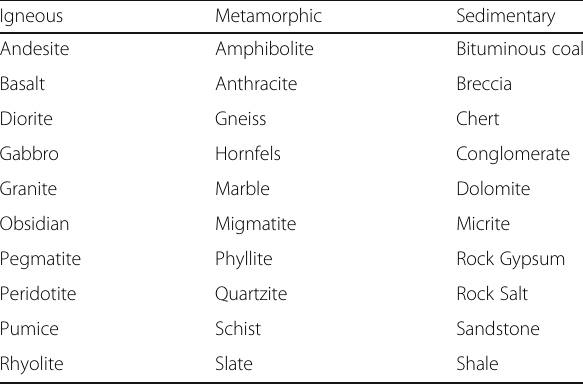
Table 1 A breakdown of the rock high levels and subtype levels used in the